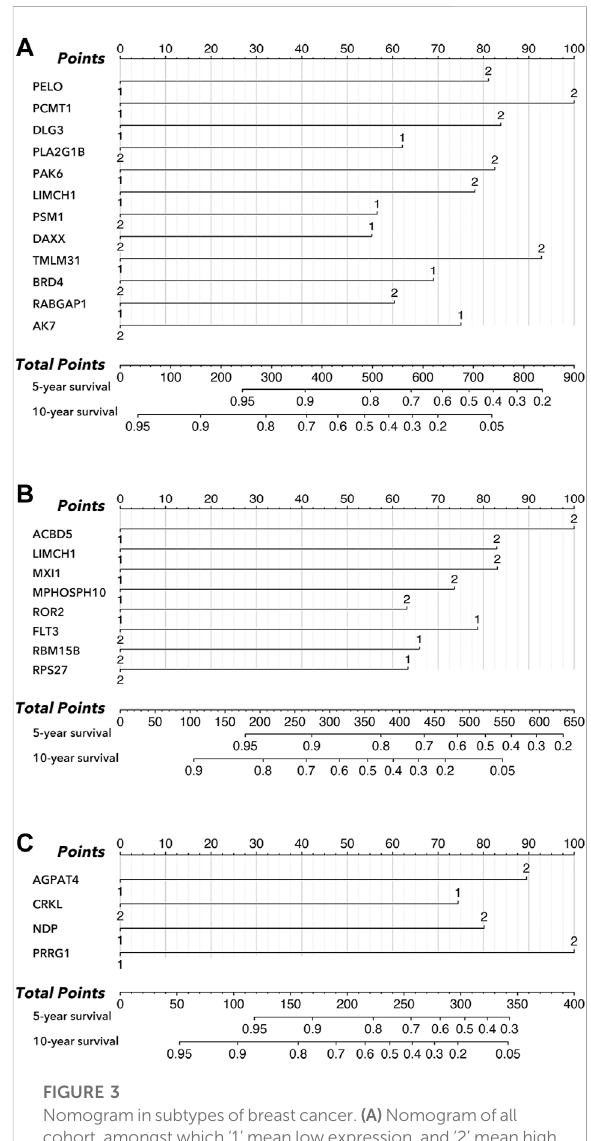
FIGURE 3 Nomograminsubtypesofbreastcancer. (A) Nomogramofall cohort, amongst which ‘ 1 ’ mean low expression, and ‘ 2 ’ mean high expression. (B) Nomogram of the luminal cohort, amongst which ‘ 1 ’ mean low expression, and ‘ 2 ’ mean high expression. (C) Nomogram of TNBC cohort, amongst which ‘ 1 ’ mean low expression, and ‘ 2 ’ mean high